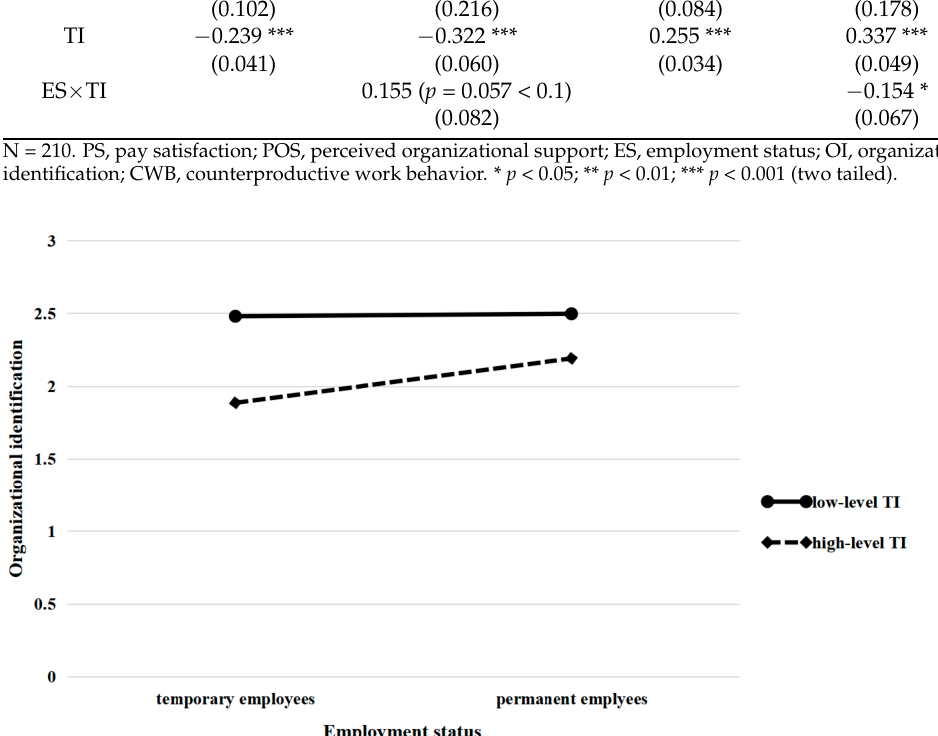
Figure 3. Interaction between employment status and turnover intention on CWB. Hypotheses 4 supposed that the mediation of organizational identification on coun- terproductive work behavior varies as a function of turnover intention. As shown in Table 6, the confidence interval of index for the moderated mediation was significant ( β = − 0.099, S. E. = 0.042, 95% C. I. = [ − 0.168, − 0.030]), indicates that the indirect effect from employment status to counterproductive work behavior was moderated by turnover intention. Besides, the conditional indirect effects were insignificant when the level of turnover intention is 1 standard deviation (SD) below the mean value ( β = 0.016, S. E. = 0.054, 95% C. I. = [ − 0.072, 0.104]). However, the conditional indirect effects were significant when the level of turn- over intention is 1 standard deviation (SD) above the mean value ( β = − 0.168, S. E. = 0.056, 95% C. I. = [ − 0.260, − 0.077]), or at mean value ( β = − 0.076, S. E. = 0.038, 95% C. I. = [ − 0.139, − 0.013]). The result illustrated that when perceiving medium or high turnover intention, temporary and permanent employees will demonstrate a significantly difference in their organizational identification and counterproductive work behavior. Thus, hypothesis 4 was supported.